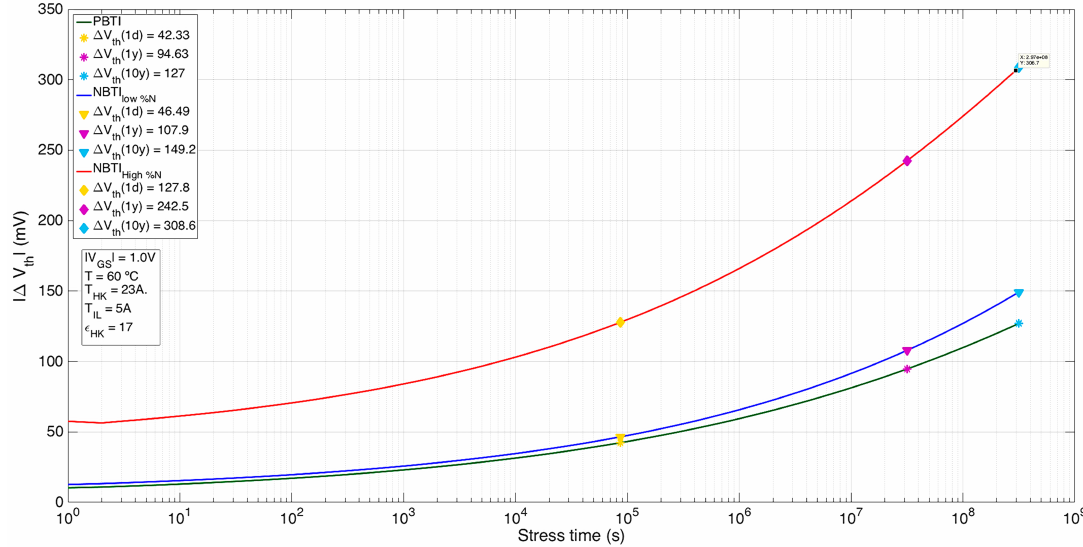
Figure 11. Comparison between NBTI and PBTI models, for long operation